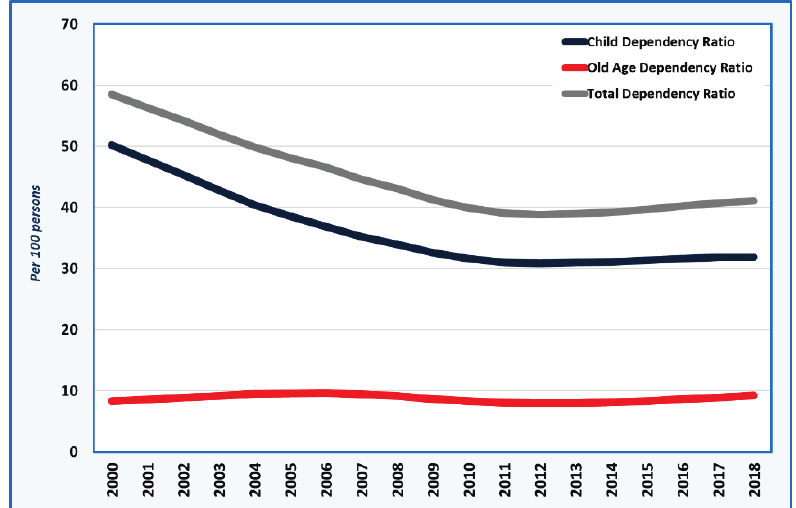
Figure 25. Dependency ratio in Azerbaijan (at the beginning of the year). Source: according to SSC